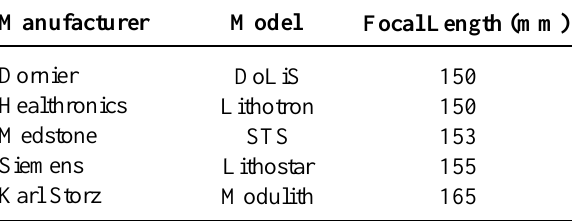
Table 4 – Lithotripter specification.